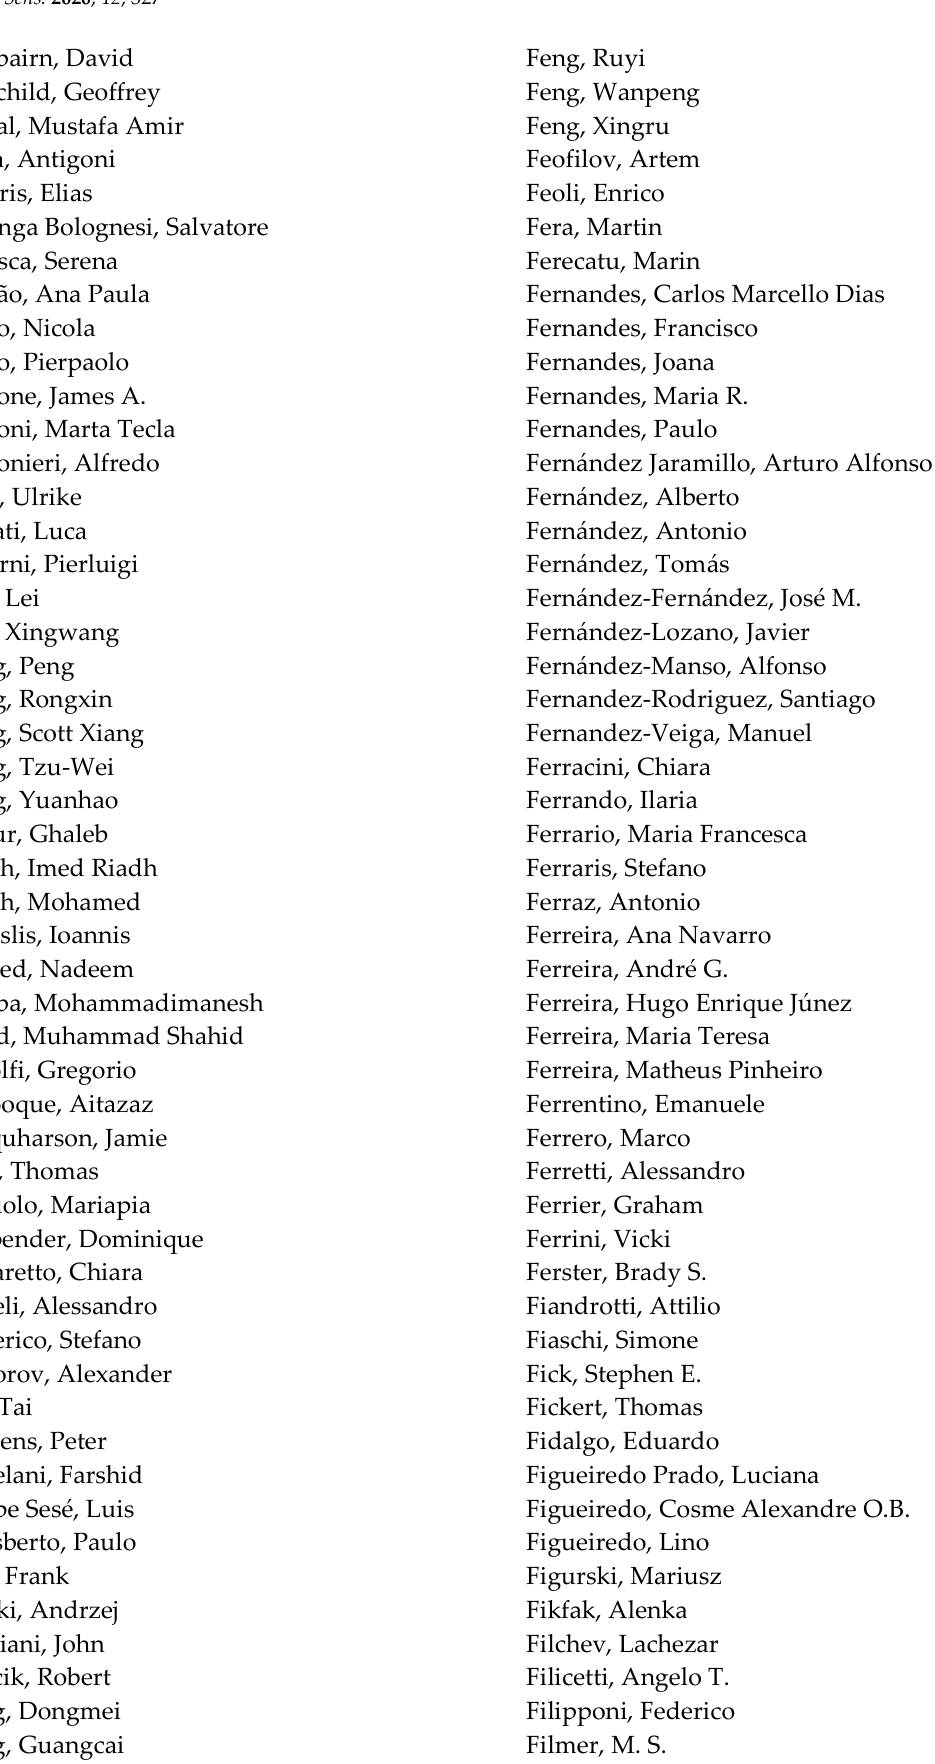
Figueiredo Prado, Luciana Figueiredo, Cosme Alexandre O.B. Figueiredo, Lino Figurski,